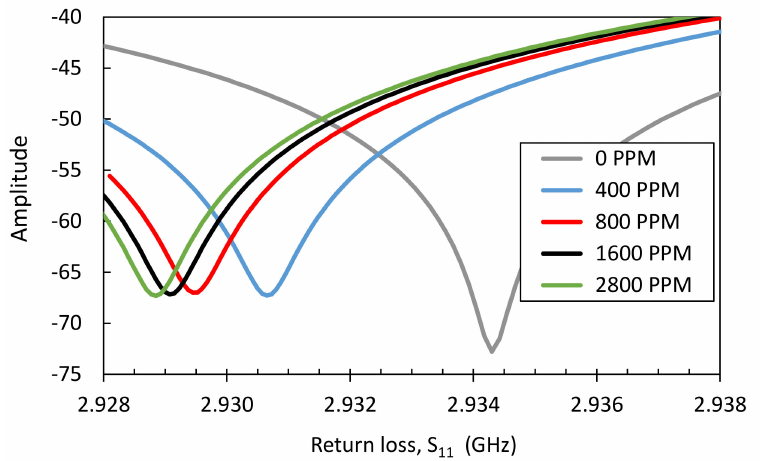
Figure 7. The return loss (S11) of the proposed sensor at different concentrations of NH 3